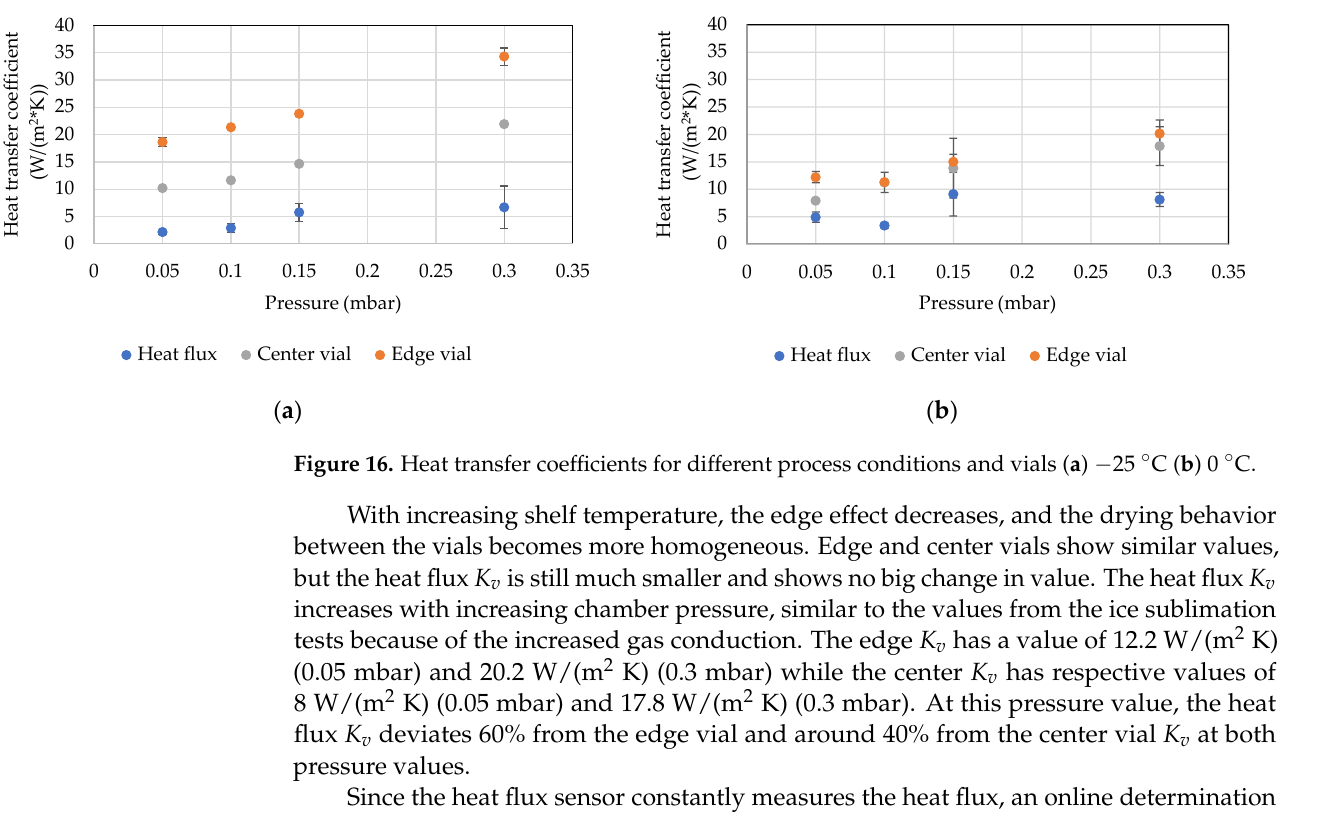
Figure 17. Vial heat transfer coefficient during primary drying duration measured with heat flux sensor (T_s= −25 °C, p _c= 0.15 mbar). Since the product temperature slowly increases and subsequently reaches the shelf temperature, the endpoint of primary drying can be detected by the heat flux sensor. As soon as the heat flux data fall below zero, the direction of heat flow changes again, and no sublimation occurs. For this measurement to be accurate, the vial bottom must be placed